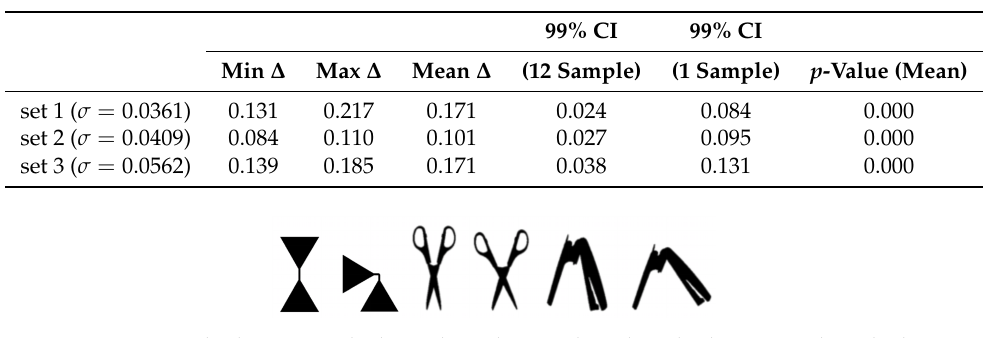
Figure 6. Some sample shapes on which geodesic distance based methods are tested. In the literature, some authors [22,23] define articulations as transformations that are rigid when restricted to a part.